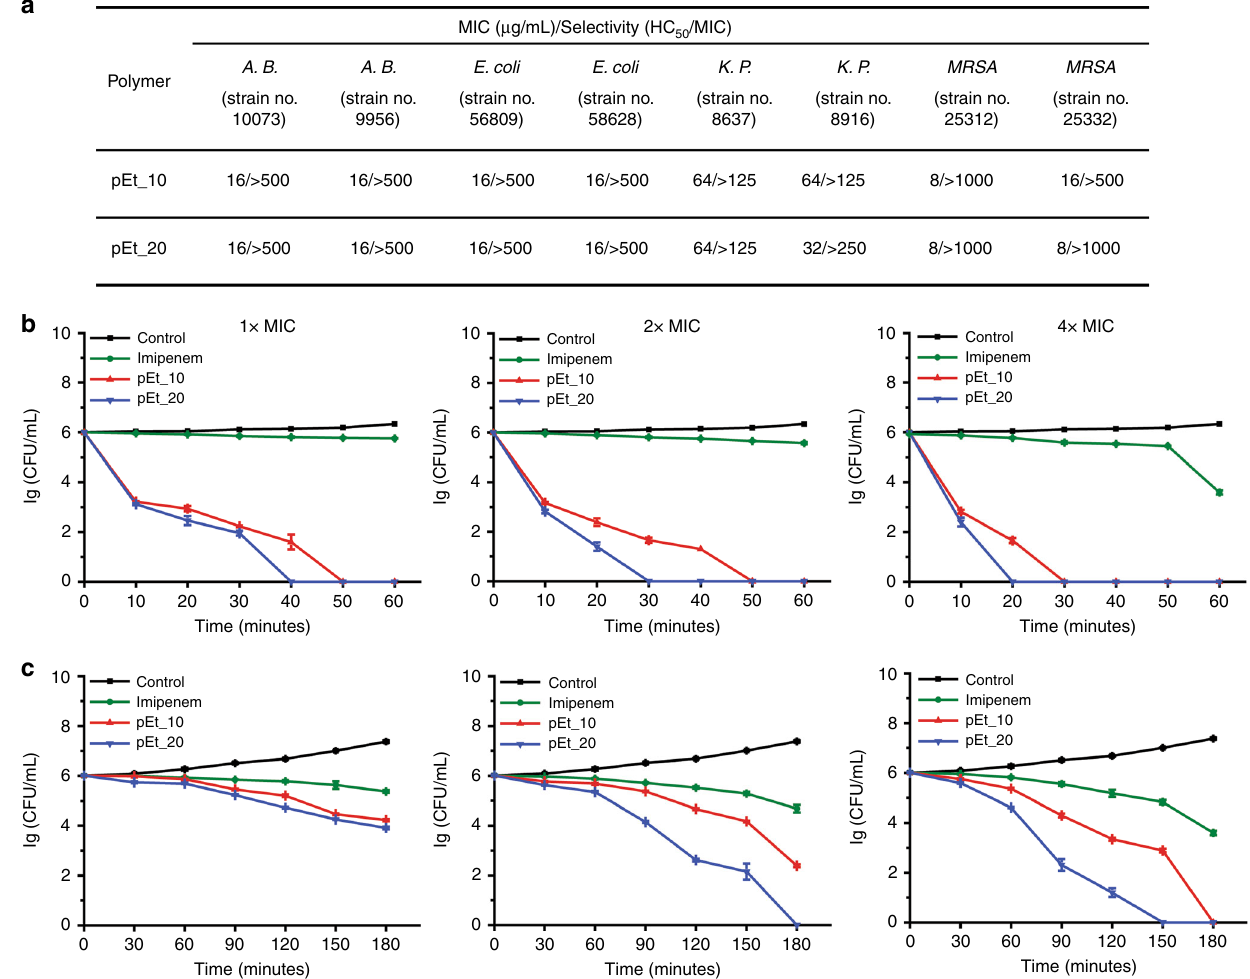
Fig. 3 Antibacterial activity of guanidinium-functionalized polycarbonates. a MIC and selectivity (HC 50 /MIC) of polymers against clinically isolated multidrug-resistant bacteria ( A . B . : A . baumannii ; K . P . : Klebsiella pneumoniae ; MIC of R 10 and R 20 : >512 µ g/mL against all the strains of bacteria tested); b killing kinetics of A . baumannii 10073 at different concentrations as speci fi ed; c killing kinetics of E . coli 56809 at different concentrations as speci fi ed. The antibiotic imipenem did not exert signi fi cant bactericidal activity against A . baumannii and E . coli after 1 and 3 h treatment, respectively, while the polymers eradicated the bacteria rapidly. An increased polymer concentration led to faster killing ef fi ciency. Error bars represent s.d. for n =